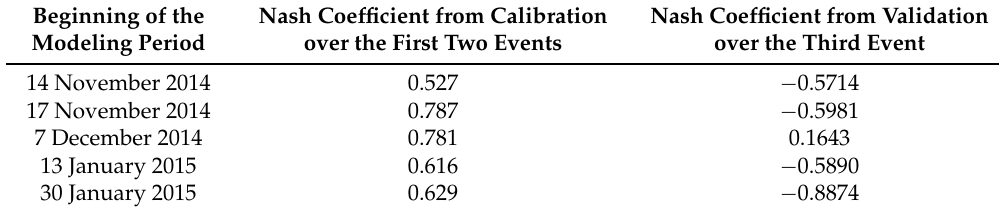
Table 8. Nash Coefficients obtained from calibration and validation over the modelling period. Beginning of